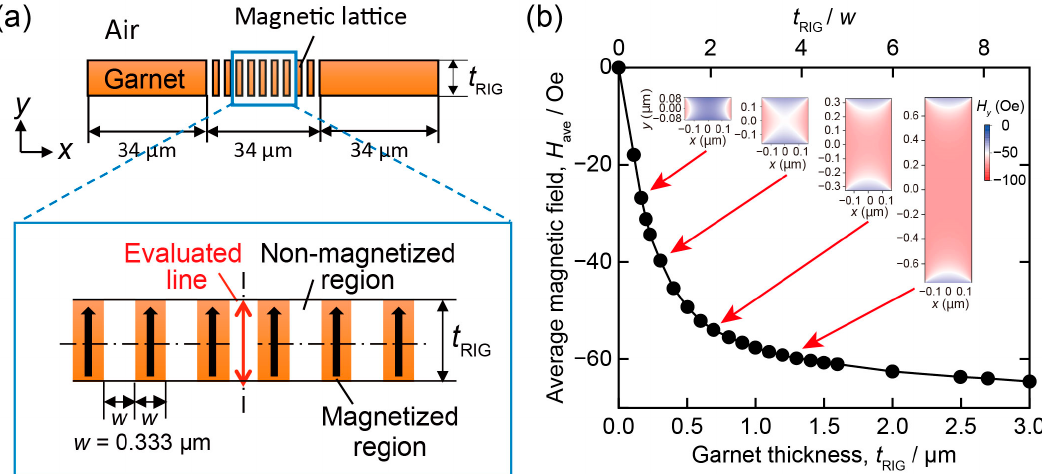
Figure 9. Calculated stray magnetic field in the magnetic fringe: ( a ) Calculation model and ( b ) the calculated average stray magnetic field along the center of a non-magnetized region and the stray magnetic field distributions in a non-magnetized region at several aspect ratios (inset). Negative values of magnetic field mean that the direction of the magnetic field is opposite to the initial direction [32].